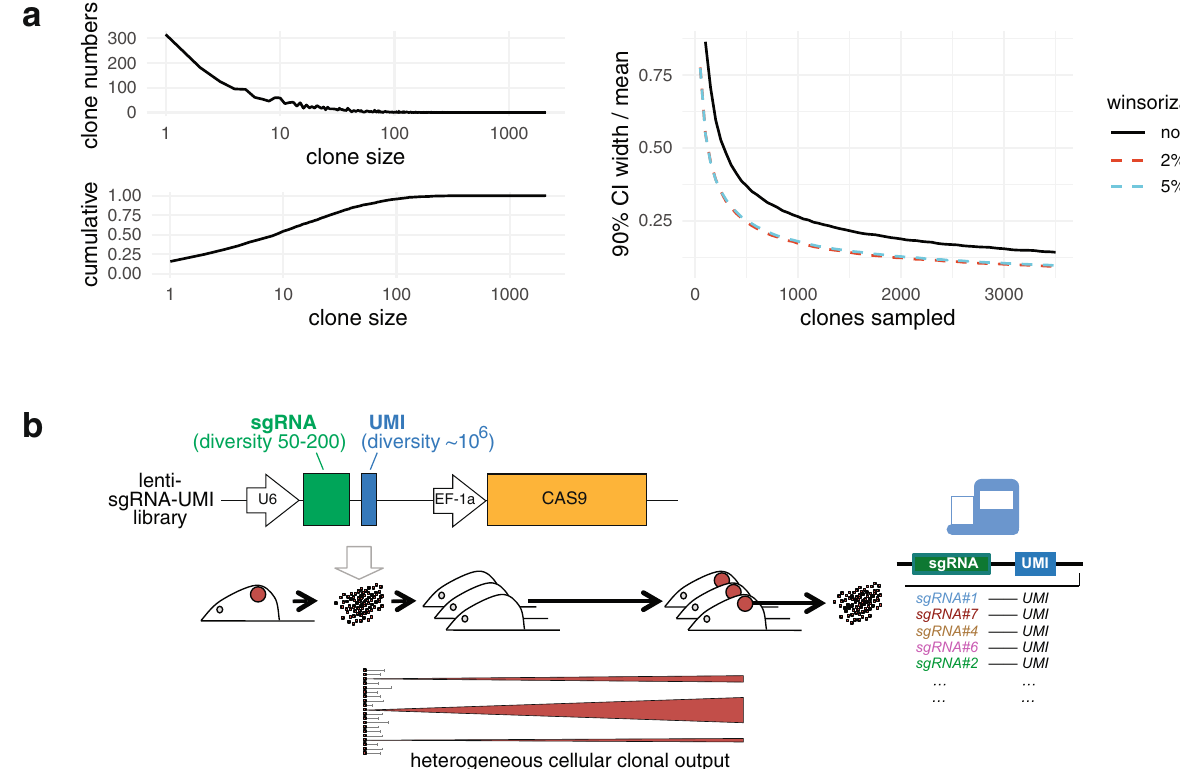
Fig. 1 Quantitative assessment of gene fi tness in vivo. a Sampling from a heavy-tailed clone distribution. Left panels show the size distribution (upper) and cumulative size distribution (lower) of clones in a barcoded PDX tumour. Right panel shows the decrease in uncertainty in the sampled population mean clone size when clones are sampled in increasing numbers. Solid line = arithmetic mean, dashed lines = winsorized mean. b Experiment schematic. PDX cells are transduced ex vivo with a CAS9-sgRNA-UMI lentiviral library, and transplanted into recipient mice. Resulting tumours are harvested, and joint sgRNA-UMI identities determined by targeted amplicon sequencing of bulk DNA. Schematic lower panel highlights that many initially transplanted cells are not represented in the fi nal tumour, and those transplanted cells that do are represented with heterogenous numbers of clonal progeny. Source data are provided as Source Data fi